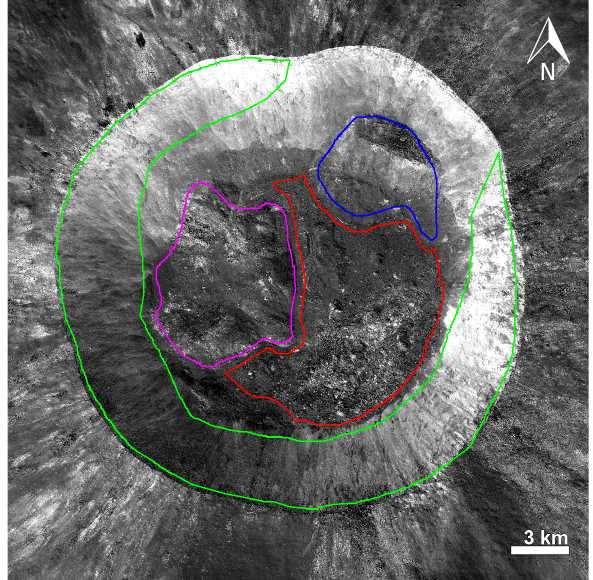
Figure 5. Giordano Bruno crater mosaic indicating regions of study: Crater floor (red), crater wall (green), NE slump (blue), and SW slump (magenta).